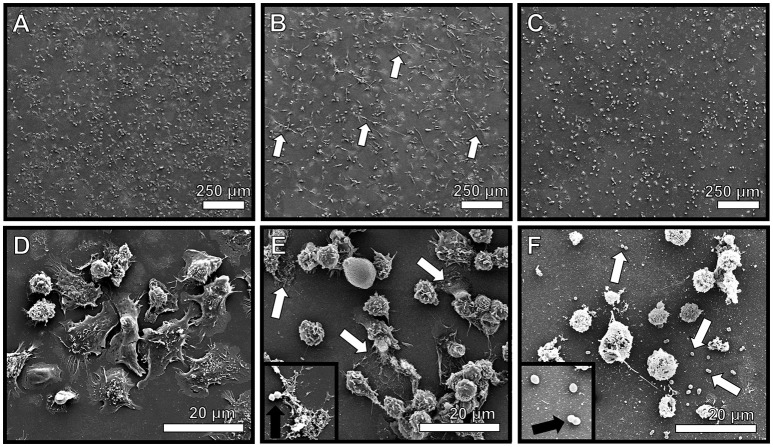
Neutrophils encountering GBS elaborate extracellular traps (NETs) comprised of extracellular DNA. High resolution scanning electron microscopy analyses reveals murine neutrophils elaborate extracellular traps in response to GBS co-culture (B,E, white arrows), a result which was not seen in uninfected mouse neutrophils (A,D). Treatment with DNAse I abrogates observation of extracellular traps (C,F, white arrows), indicating traps are structurally comprised of DNA. Inset panels of (E,F) show GBS associated with NET fibers or not associated with NETs due to DNA degradation, respectively (black arrows).